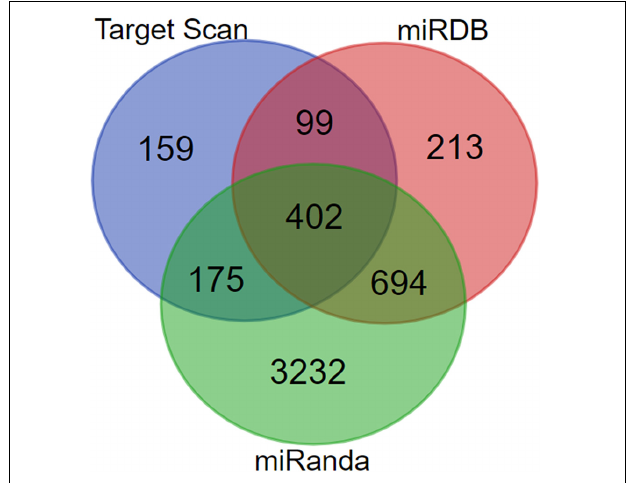
FIGURE 3 | Construction of miR-181a-5p target gene